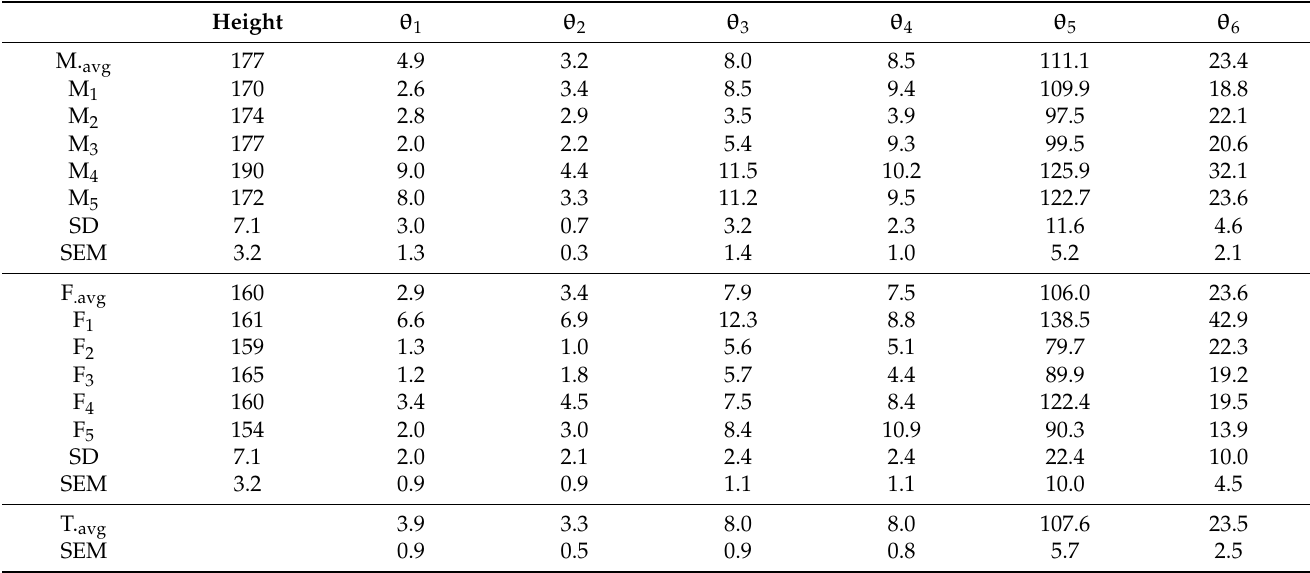
Table 3. Data collection for the ROM ( ◦ ) for males and females (external and internal